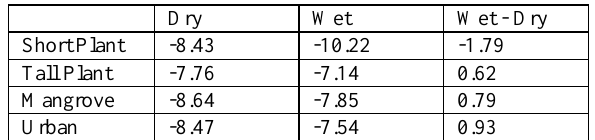
Table 2. Average dry and wet scattering values according to the four land cover classes (unit: dB)